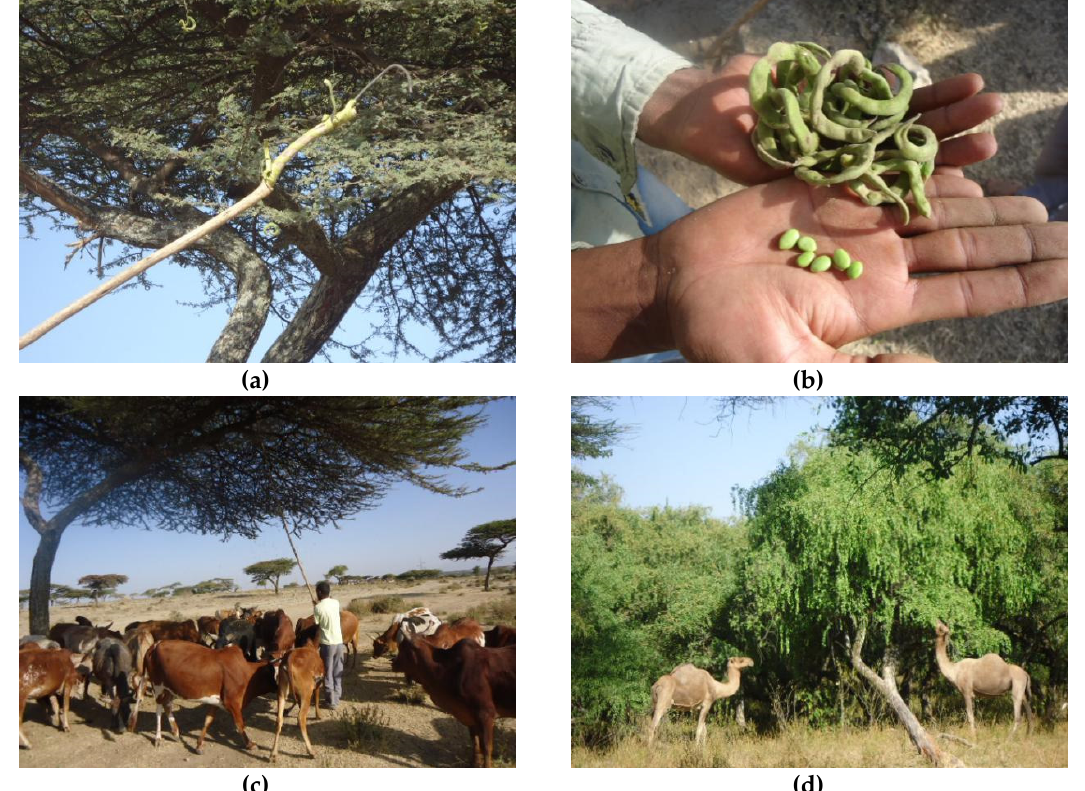
Figure 5. ( a ) A farmer shaking acacia trees with a hooked long stick to drop seed pods; ( b ) the seeds and pods; ( c ) feeding cattle with the seeds and pods; ( d ) camels feeding acacia trees. Source: Authors.